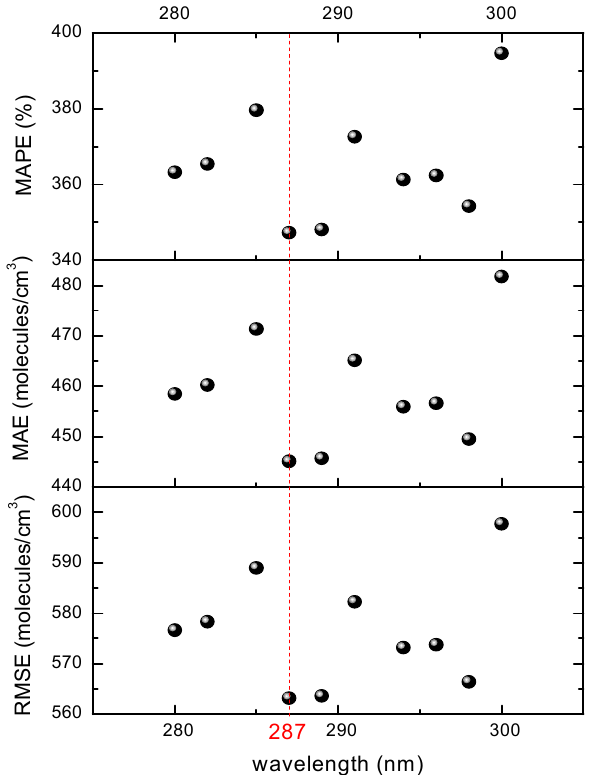
Figure 6. SO 2 single-wavelength error distribution. The red dot line indicates that the inversion using wavelength of 287 nm has the smallest error.